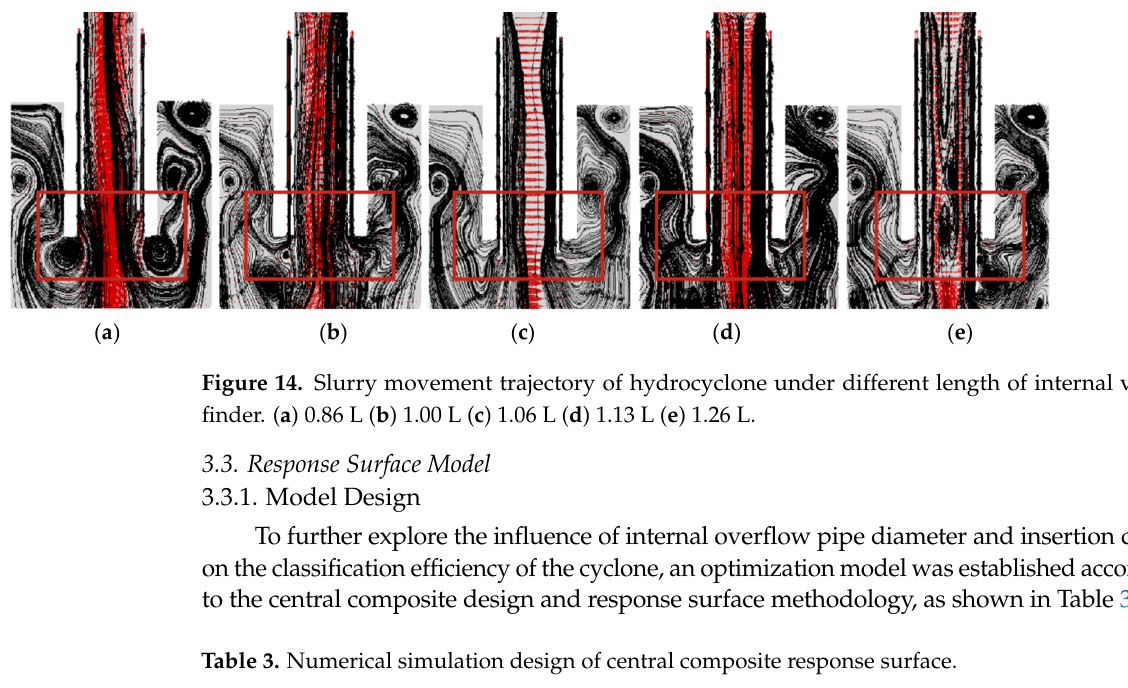
Table 3. Numerical simulation design of central composite response surface. Test No.